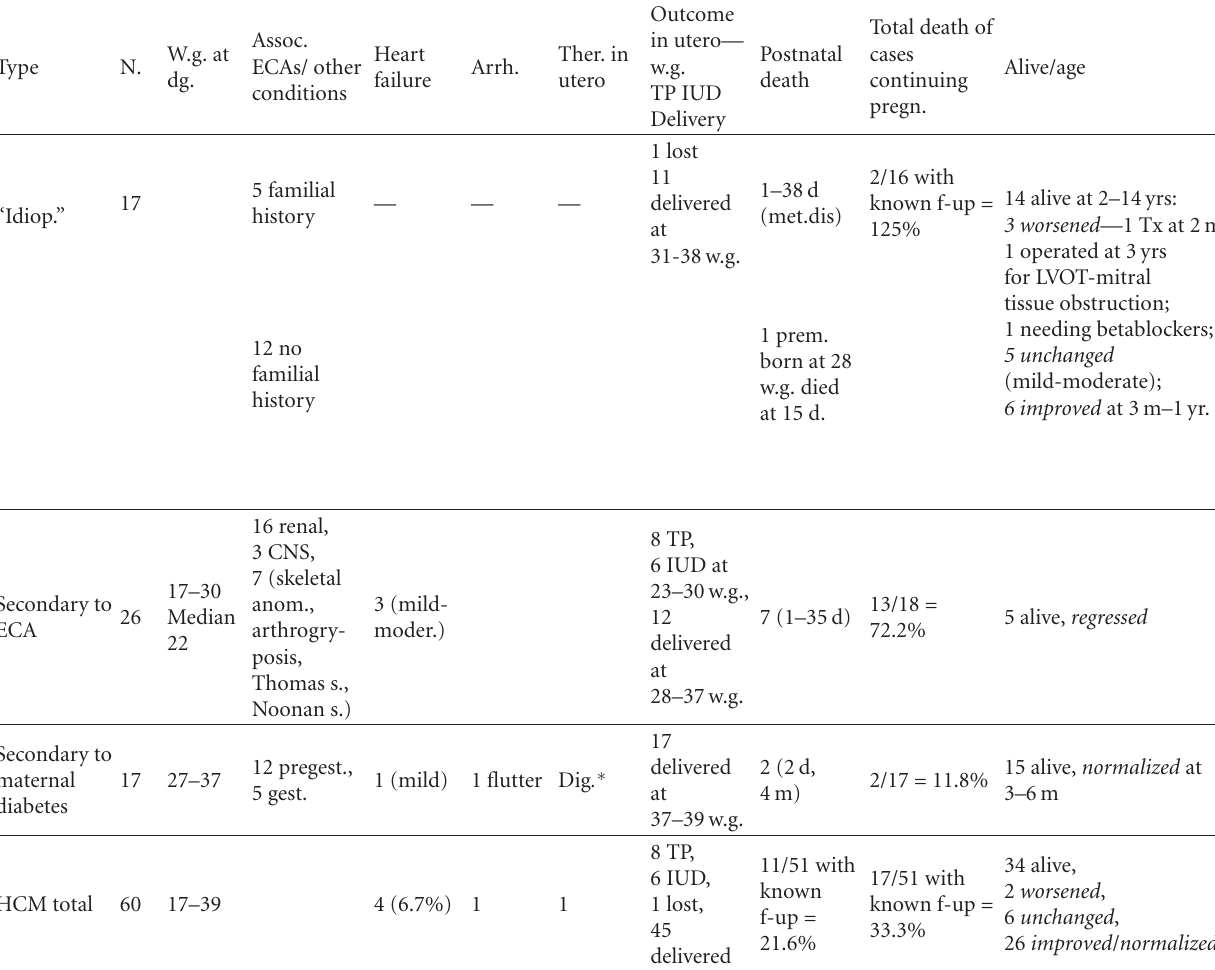
Table 2: Data of cases with